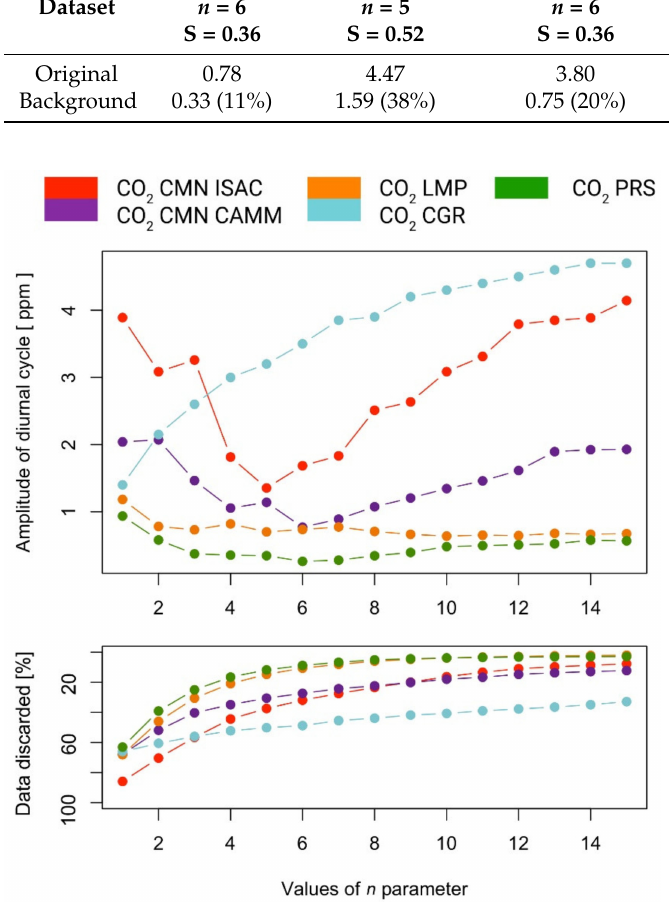
Figure 2. Top: median values of the CO 2 diurnal cycle amplitudes (calculated over the whole dataset) as a function of parameter n . Bottom: percentage of non-background data discard for each dataset after the application of BaDS. For CMN—ISAC and CMN—CAMM only nighttime data from May to September are considered in Step 1 of the procedure (see text). Similarly, only daytime data are used in Step 1 of the procedure for